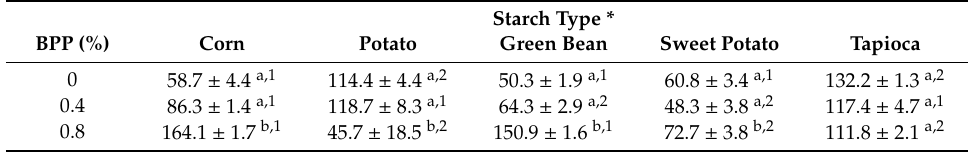
Table 1. The total UV absorption of films made from di ff erent types of starch with di ff erent starch and blueberry pomace levels.